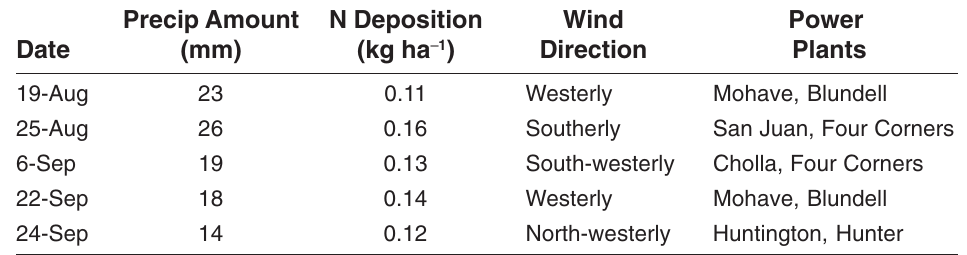
Back-Trajectory Analyses using